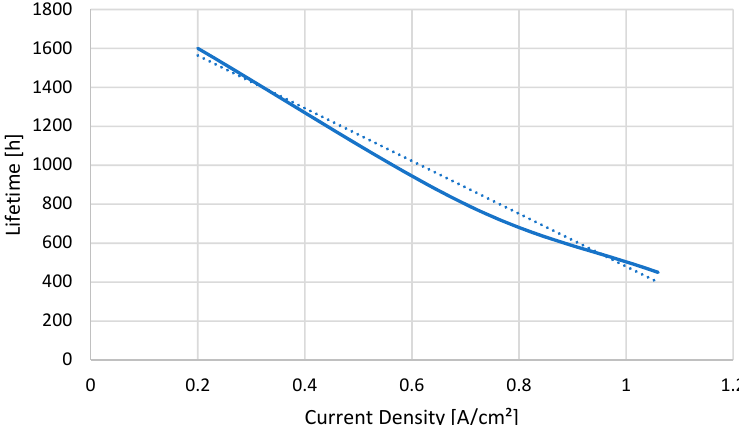
Figure 8. Current Density—FC aging model.